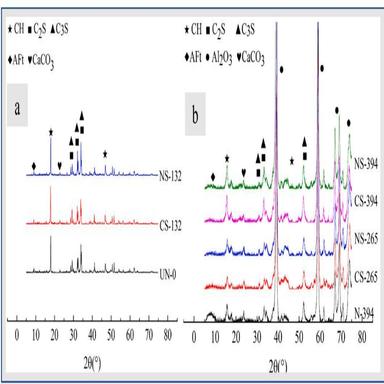
XRD diffraction spectra: (a) Before subsequent hydration and at 132d; (b) Subsequent hydration at 265d and 394d. \Note: UN-0 refers to specimens without subsequent hydration, CS-132 denotes the CS specimens after 132d of subsequent hydration, NS-132 represents the NS specimens after 132d of subsequent hydration, CS-265 denotes the CS specimens after 265d of subsequent hydration, NS-265 represents the NS specimens after 265d of subsequent hydration, CS-394 denotes the CS specimens after 394d of subsequent hy